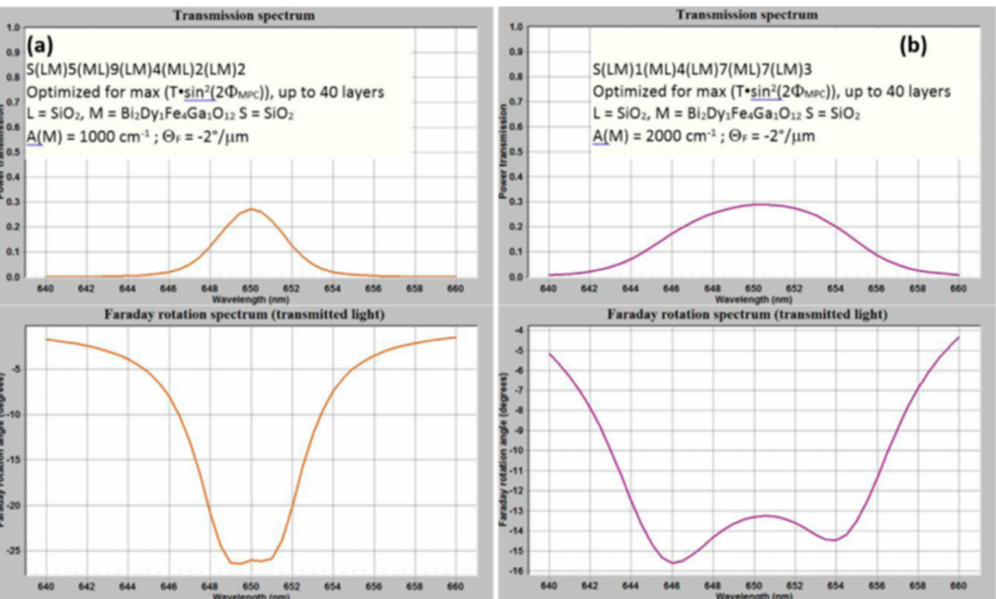
Figure 5. Calculated spectral performance parameters for multi-defect (four-defect structures, having up to 40 total layers) MPC optimized by exhaustive computation to achieve a maximum light intensity modulation capability (maximized value of parameter (T · sin 2 (2 Φ MPC )), for n(M) = 2.376, n(L) = 1.458, and using two di ff erent optical absorption coe ffi cients for magnetic material at 650 nm (a) α = 1000 cm − 1 and (b) α = 2000 cm − 1 . These refractive index and absorption coe ffi cients were considered constant withinthedesign-specificwavelengthregion, aswellasgyration(–0.02), correspondingtoapproximately 2 ◦ / µ m near 650 nm. The graphical information is reproduced from